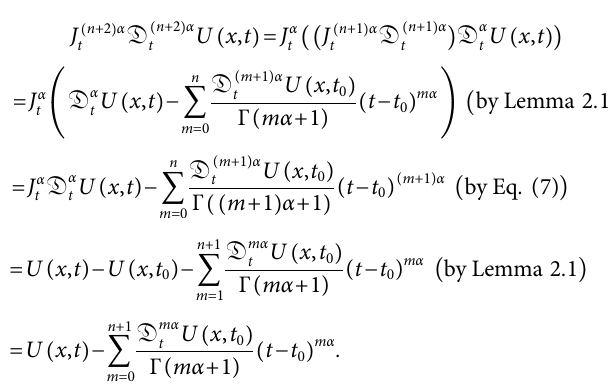
FIGURE 1 | Surface graphs of the fi fth AS of U values of α : (A) α (cid:2) 0 . 7, (B) α (cid:2) 0 . 85, (C) α (cid:2) 1, and (D) ES when α (cid:2) 1.